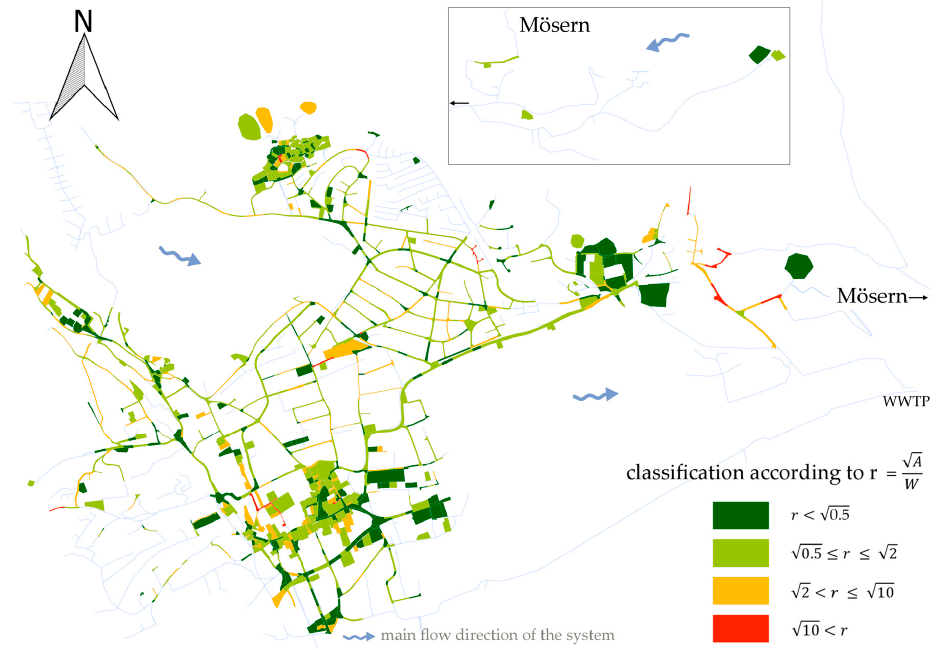
Figure 1. Classification of the subcatchments according to their initial width.